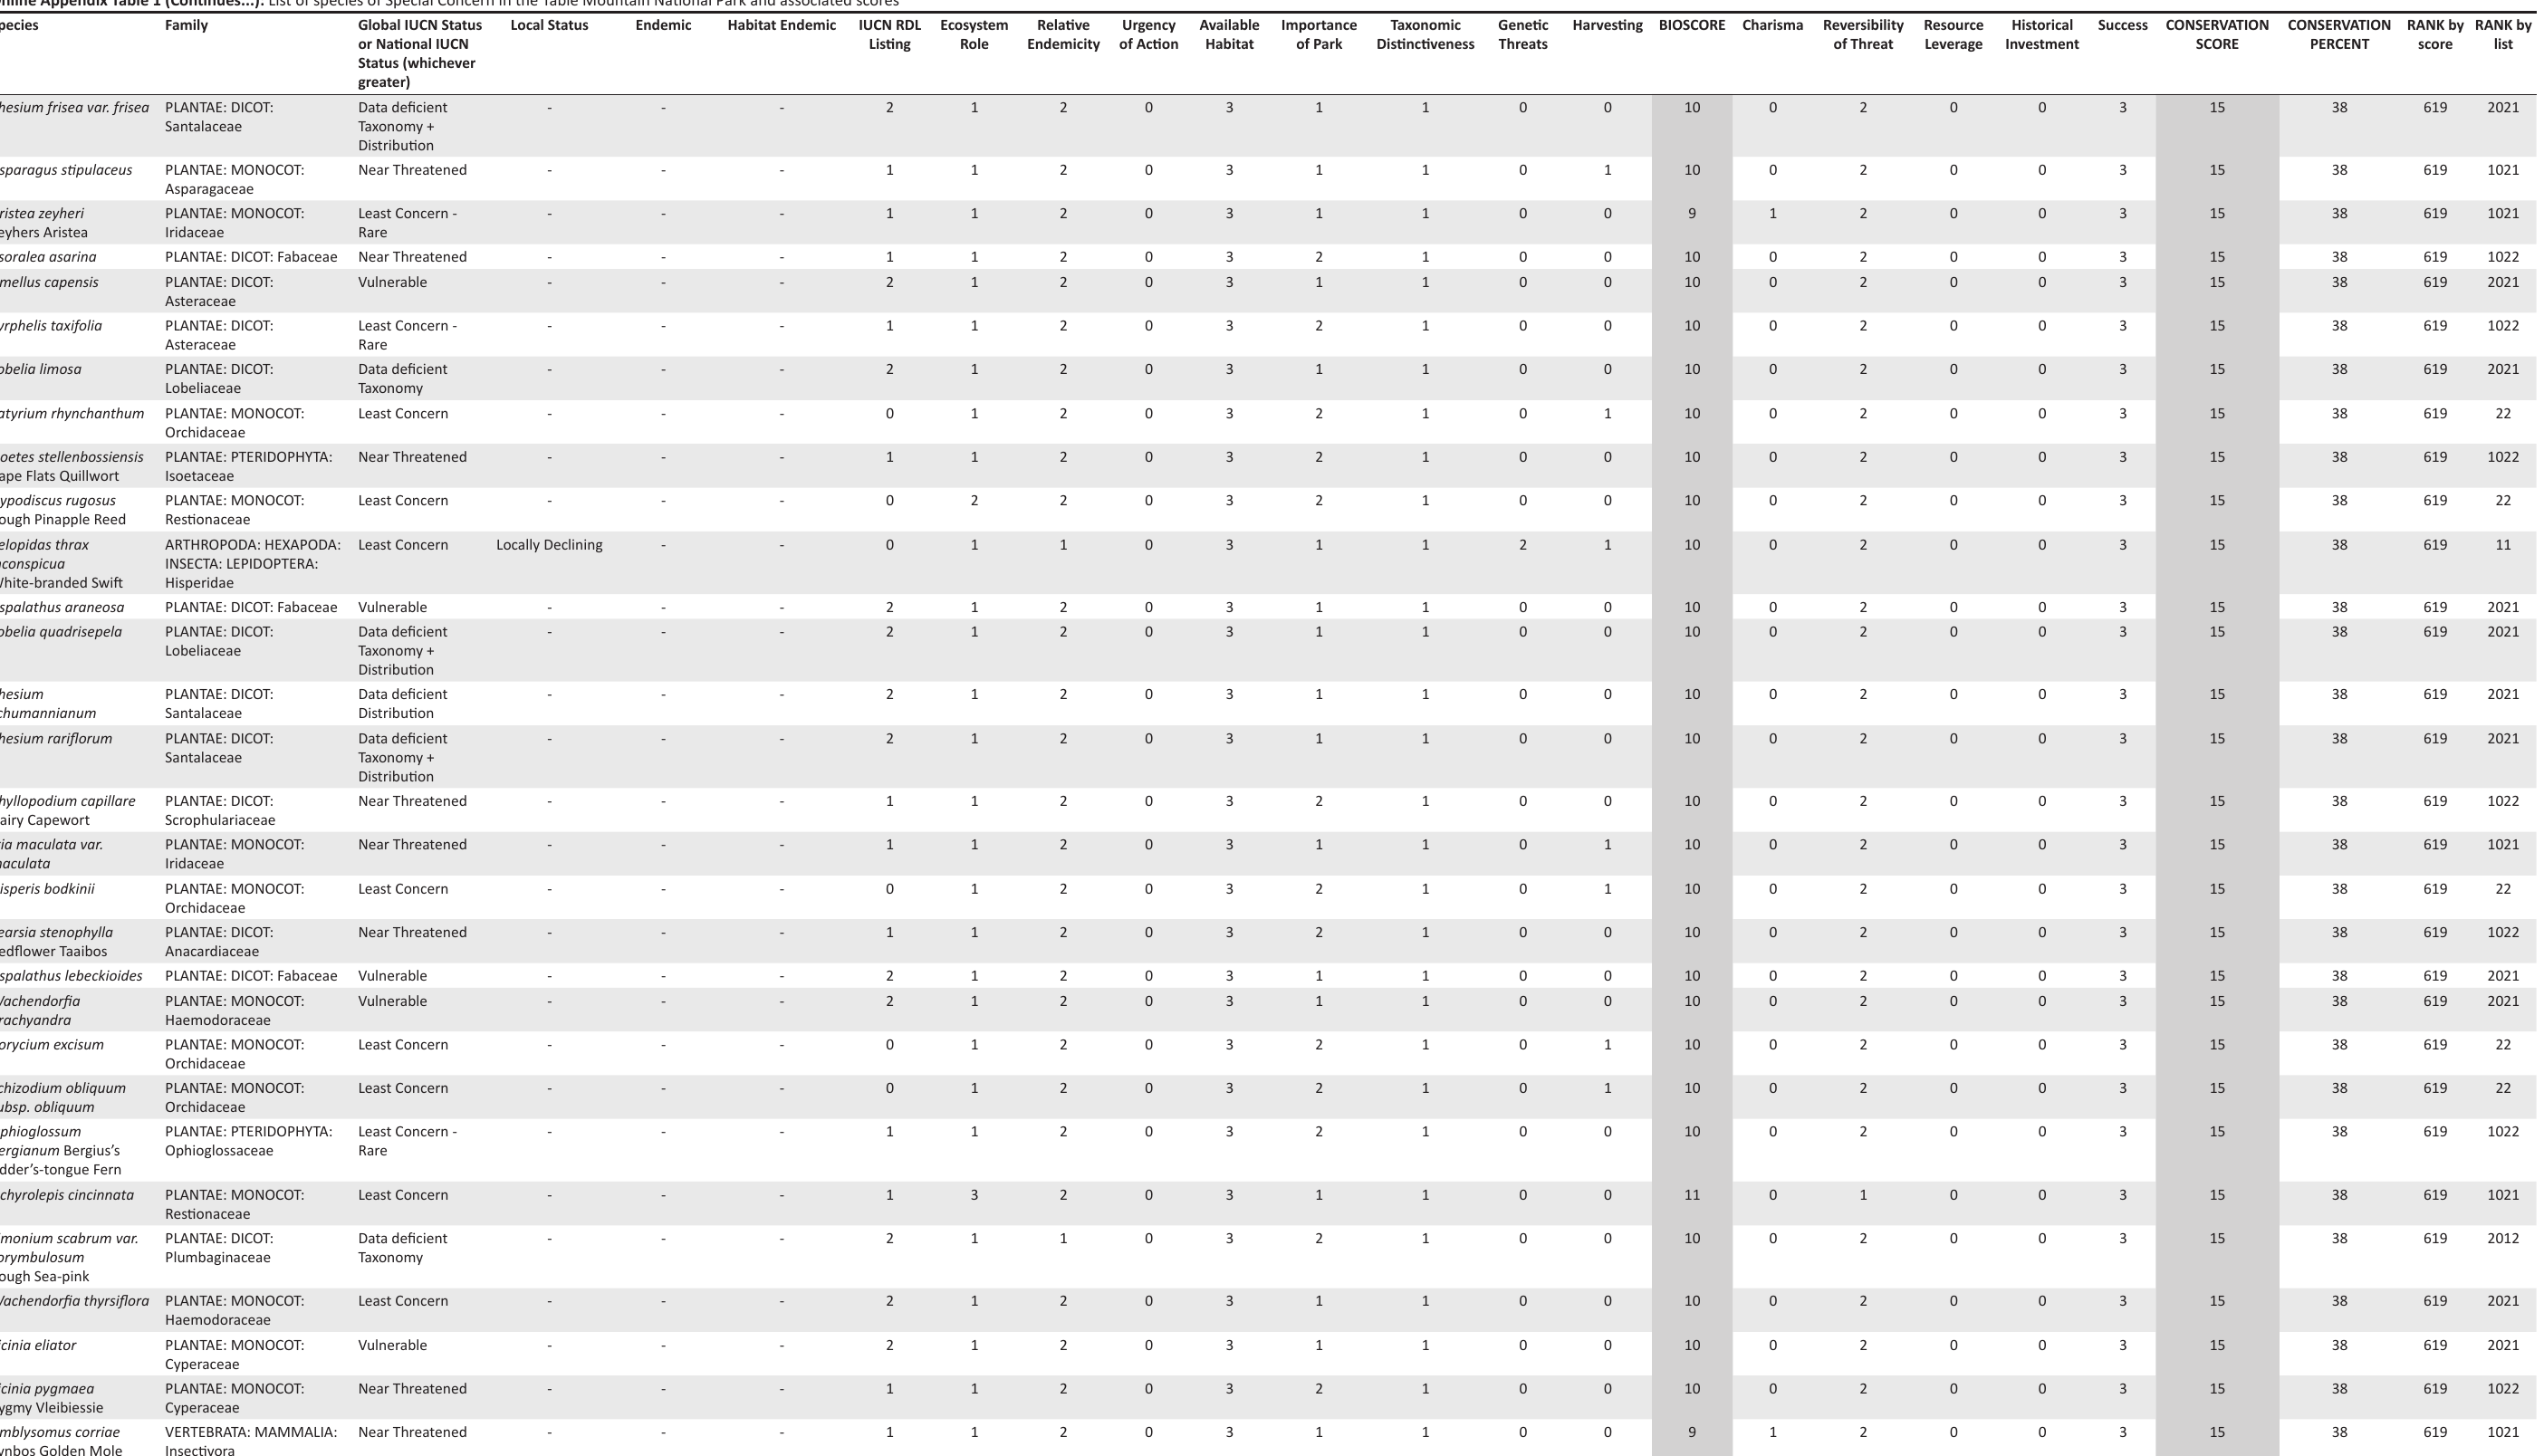
Online Appendix Table 1 (Continues...): List of species of Special Concern in the Table Mountain National Park and associated